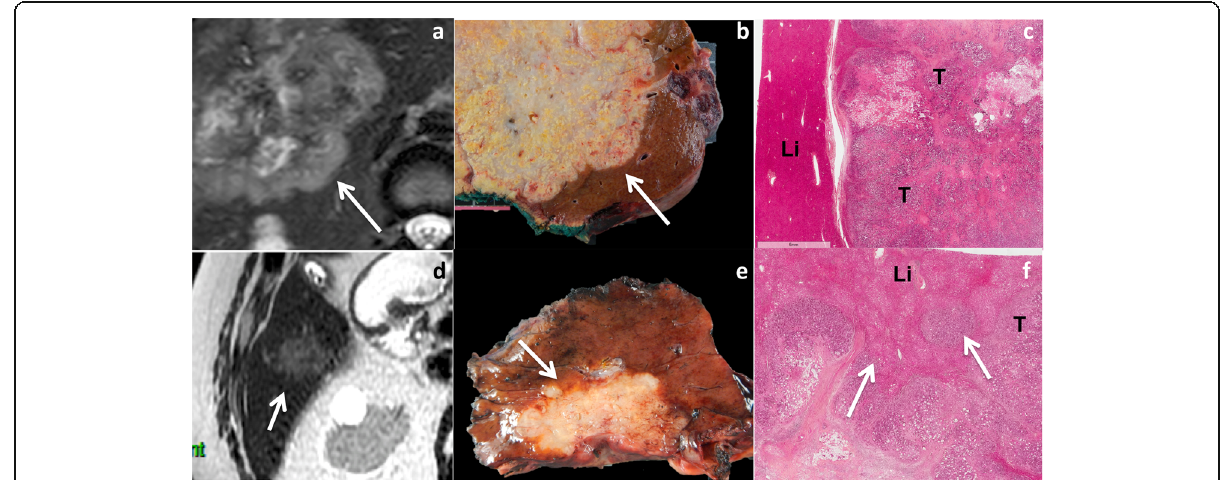
Fig. 1 Examples of gross pathology and histological analysis of pushing ( a – c ) and infiltrative ( d – f ) growth patterns in non-otherwise specified (NOS) adenocarcinoma liver metastases in a 54-year-old female patient with metastatic rectal cancer, and a 71-year-old male patient with metastatic rectal cancer, respectively. In the pushing pattern, tumor borders appear well-delineated both on T2-weighted MR images and gross pathology ( a , b — arrows), while they are slightly more ill-defined with the infiltrative pattern ( d , e — arrows). The difference in the two patterns is clearly observed on histological analysis: the pushing pattern ( c ) shows liver cells (Li) compressed by the tumor (T) without tumor cells in the hepatic plates. The infiltrative pattern ( f ) is characterized by the invasion of the liver (Li) parenchyma by tumor cells (T — arrows)